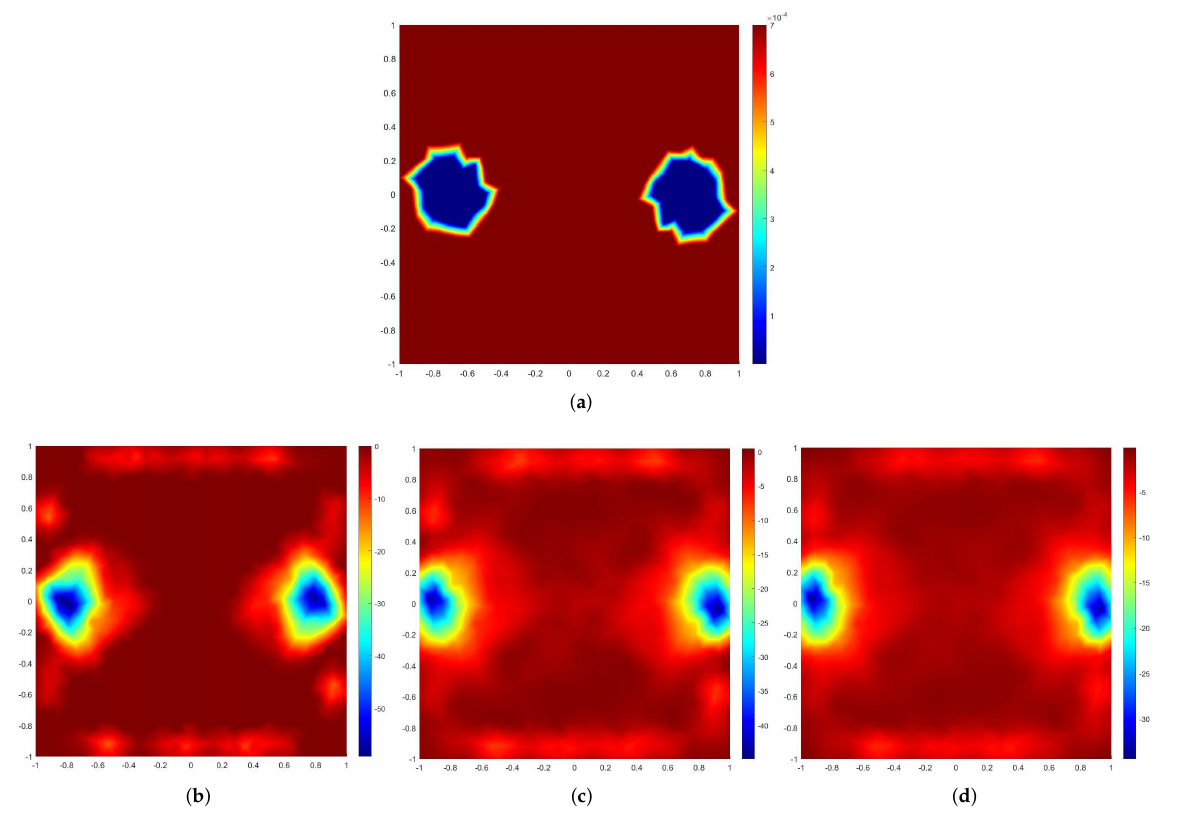
Figure 3. Example 3. ( a ) True resistive distribution. ( b – d ) Solution by FTV-MMIRGN (second row) at different values of p , 0.8, 1, and 1.8 from left to right,